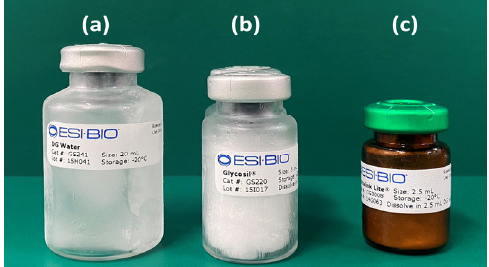
Figure 2. A cross-linkable hyaluronic acid kit, Hystem ® , consisting of: ( a ) degassed (DG) water; ( b ) hyaluronic acids possessing –SH functional groups (Glycosil ® ); and ( c ) thiol-reactive polyethylene glycol diacrylate (PEGDA) cross-linker (Extralink Lite ® ).